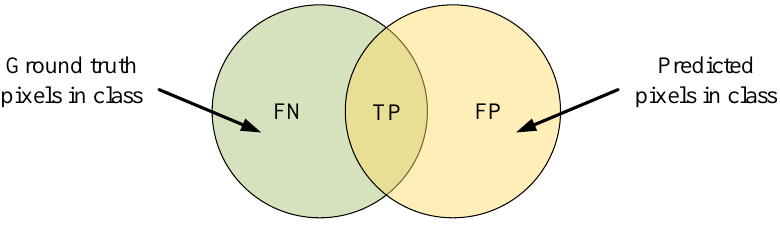
Figure 8. The standard Jaccard Index, in which TP, FP, and FN are the numbers of true positive, false positive, and false negative pixels.